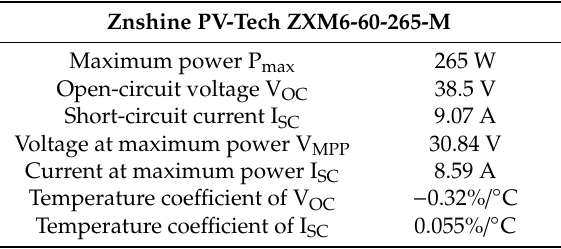
Table 3. First system—PV panel characteristics under STC.